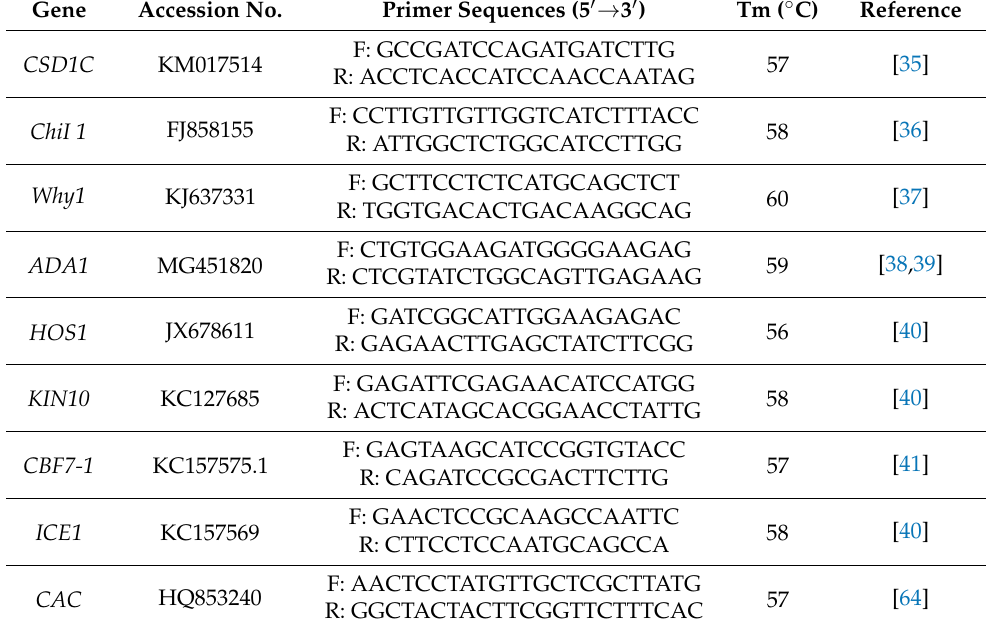
Table 1. Oligonucleotide primers used for qRT-PCR analysis.